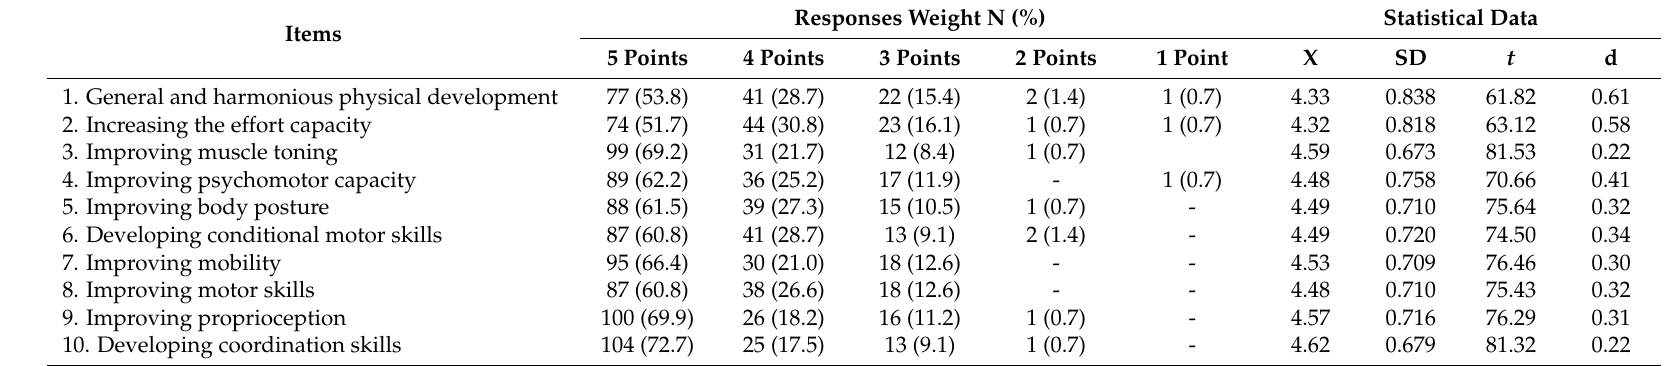
Table 1. Descriptive statistics of the motor part of the questionnaire of benefits of practicing recreational figure skating.